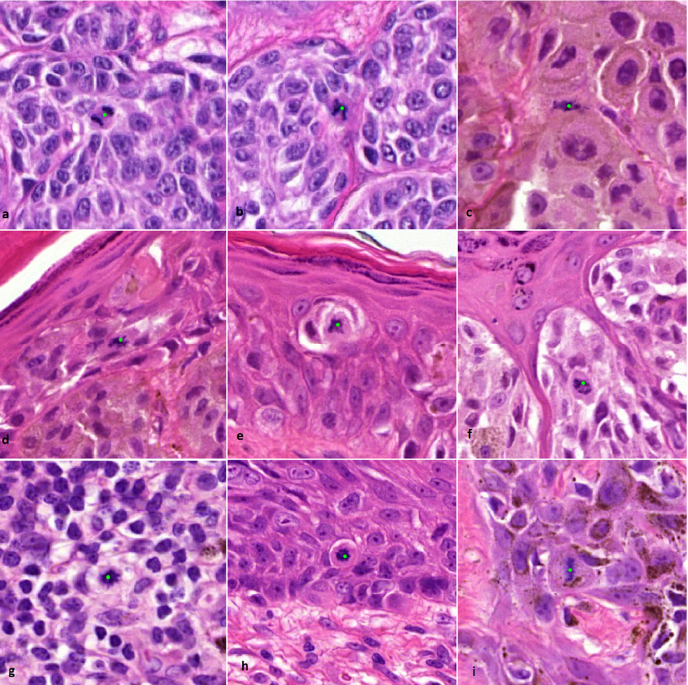
Figure 1. Examples of correctly indicated lesional and non-lesional mitoses by the algorithm (×800 magnification). ( a – c ) Dermal mitosis in a melanocyte. ( d – f ) Epidermal mitosis in a melanocyte. ( g ) Dermal mitosis in an inflammatory cell. ( h , i ) Epidermal mitosis in a (pigmented) keratinocyte. Classification of indicated mitoses and type of cell origin was performed by an experienced pathologist